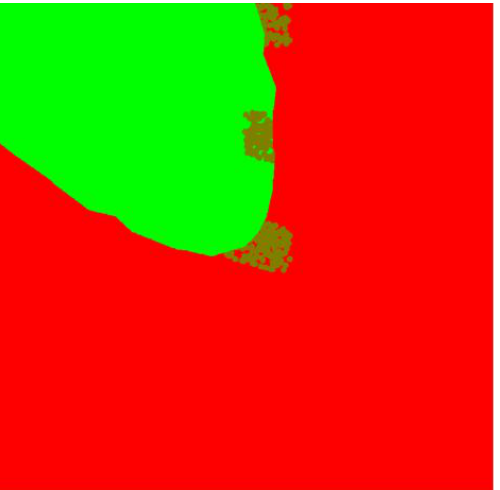
Figure 2. Helstrom classification with highlighted points classified incorrectly.